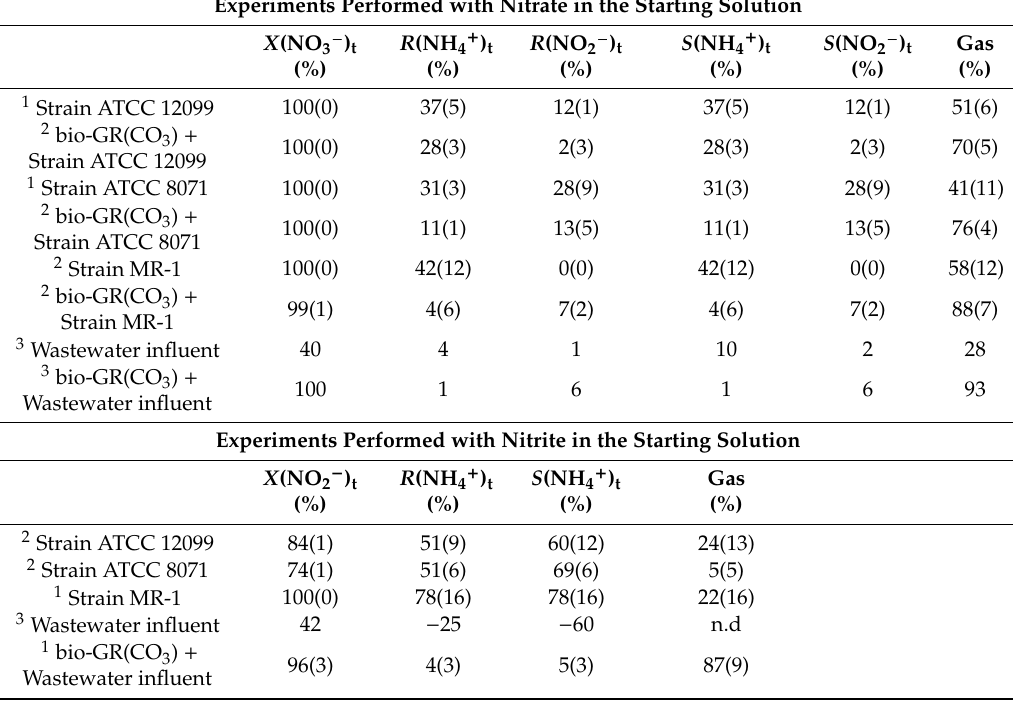
Table 3. Dissolved nitrogen speciation during bacterial nitrate and nitrite reduction in the presence or absence of biogenic iron (II-III) hydroxycarbonate green rust, referred to as “bio-GR(CO 3 )”. Experiments Performed with Nitrate in the Starting